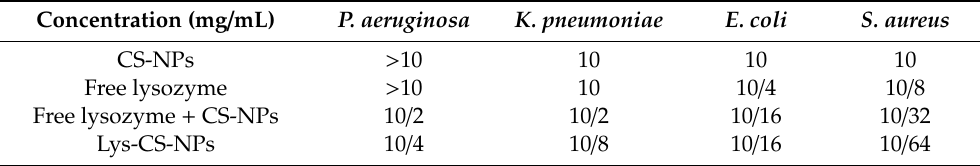
Table 1. Inhibition of different strains as a planktonic population. MIC, minimum inhibitory